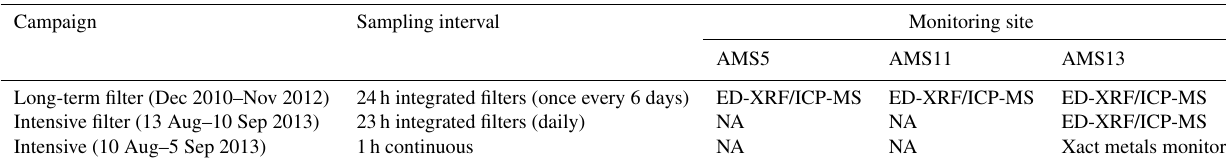
Table 1. Summary of the measurement strategy used during the two campaigns.